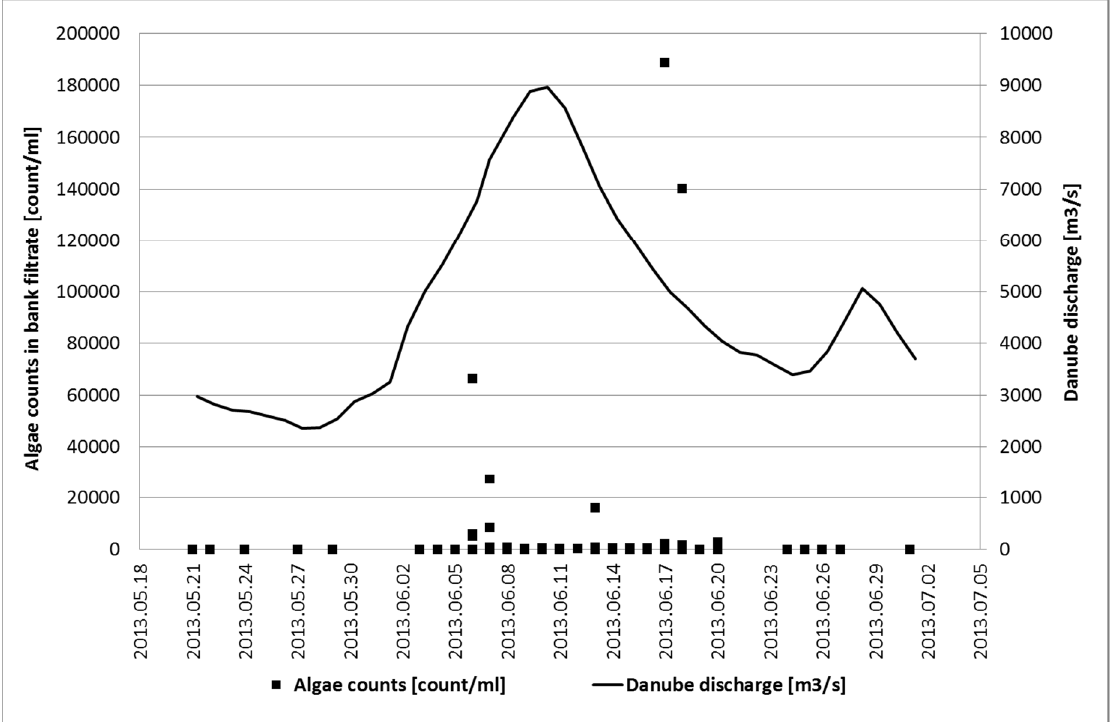
Figure 5. Algae counts in bank filtrate and Danube discharge values during a flood event in 2013.